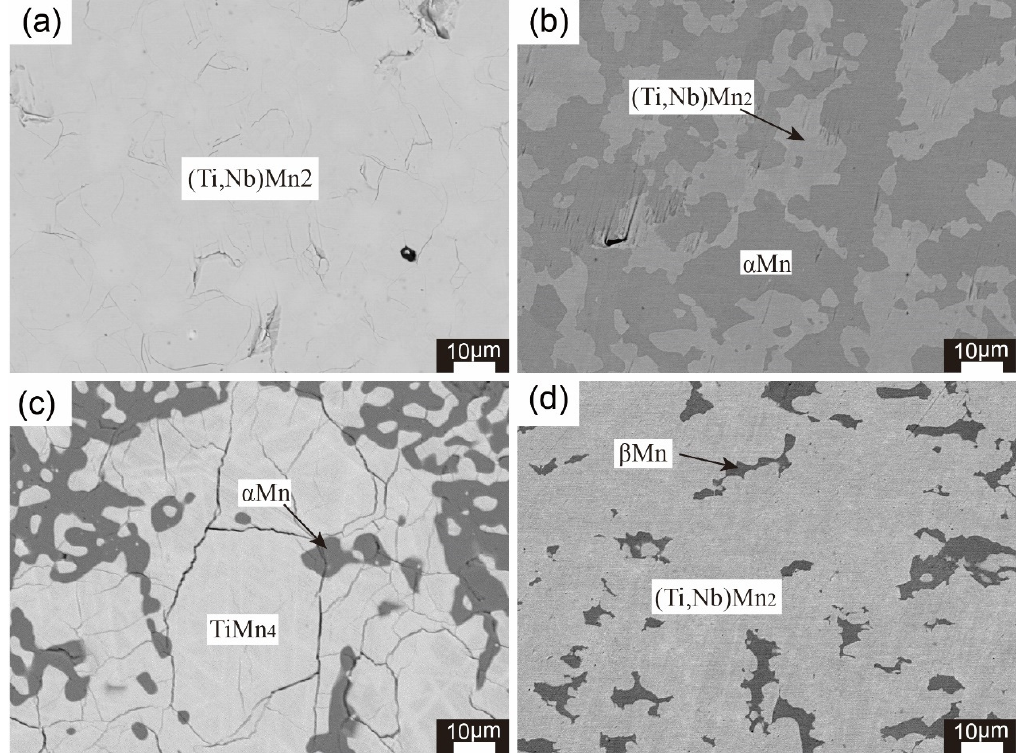
Figure 23. BSE images of alloys annealed at 1273K for 60 days: ( a ) B14, ( b ) B22, ( c ) B21, ( d ) B24.